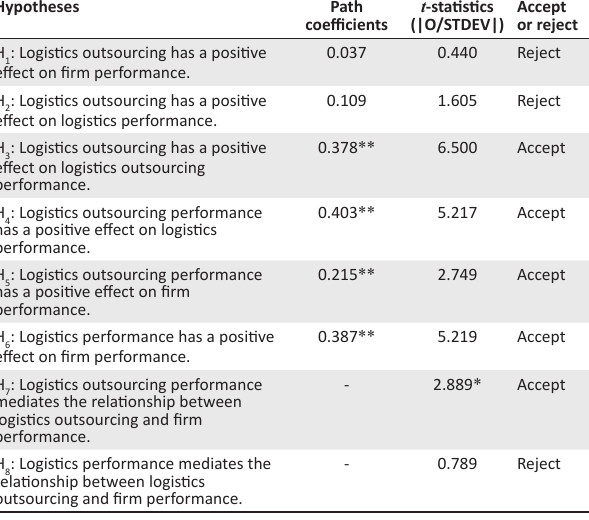
TABLE 4: Significance of path